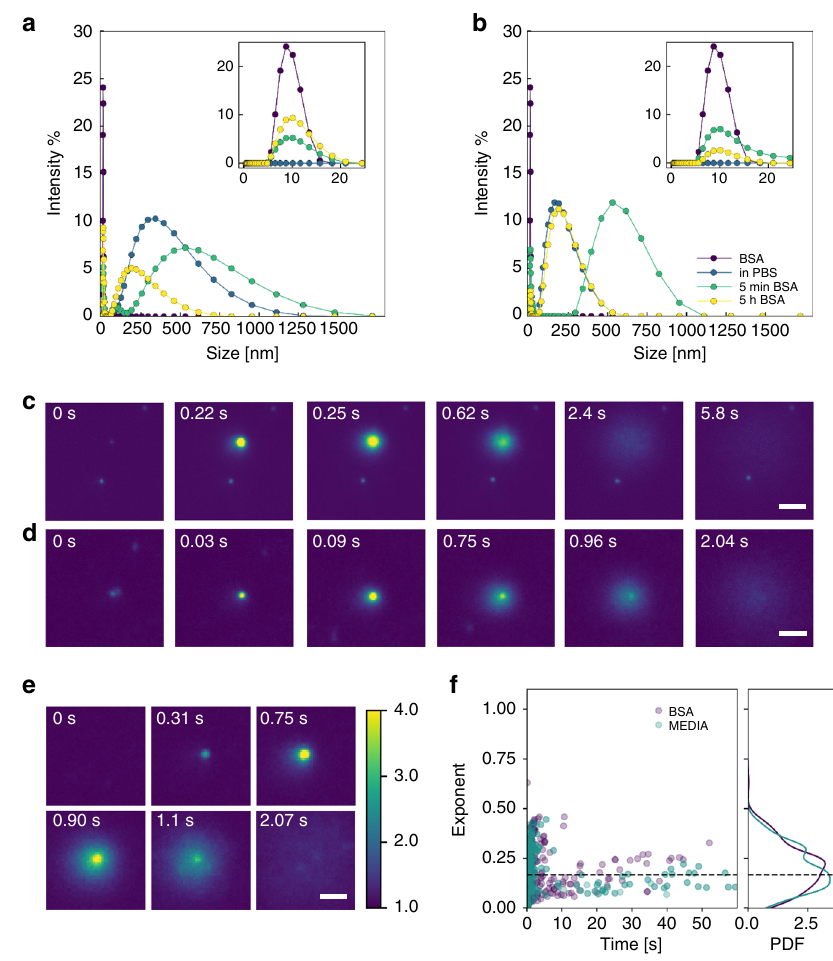
Fig. 7 Protein corona in fl uence on cubosome – bilayer interactions. a DLS measurements on MO cubosomes in BSA. b DLS measurements on 1% DOTAP cubosomes in BSA. The results for pure BSA in PBS, cubosome in PBS, cubosome in BSA – PBS for 5 min and for 5 h are shown as the purple, blue green and yellow circles, respectively. c TIRF snapshots of a single MO cubosome with DOPC in BSA – PBS environment. d TIRF snapshots of a single cubosome fusion event between 1% DOTAP and 40% DOPS 30% CHOL within BSA – PBS environment. Scale bar 1.5 µ m. e TIRF snapshots of a single cubosome fusion event between 1% DOTAP and 40% DOPS 30% CHOL within complete media environment. f Distribution of fusion times and fi tted exponents for 1% DOTAP cubosomes with 40% DOPS 30% CHOL bilayer in BSA – PBS (Purple) and complete media